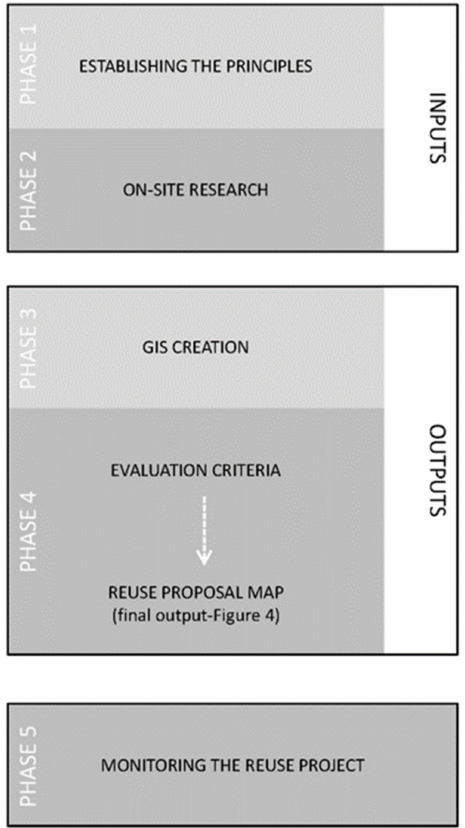
Figure 10. Diagram illustrating the phases of the reuse